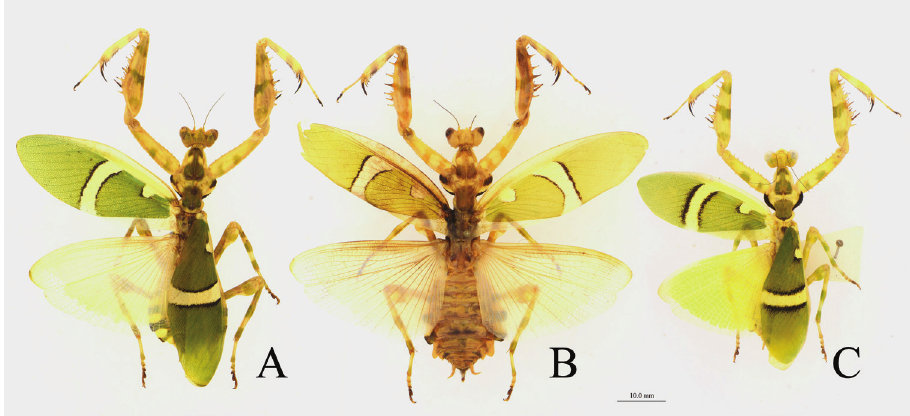
Figure 3. Female Theopropus spp. body in dorsal view A T. sinecus sinecus from Guangxi B T. xishiae sp. nov. paratype C T. sp. from